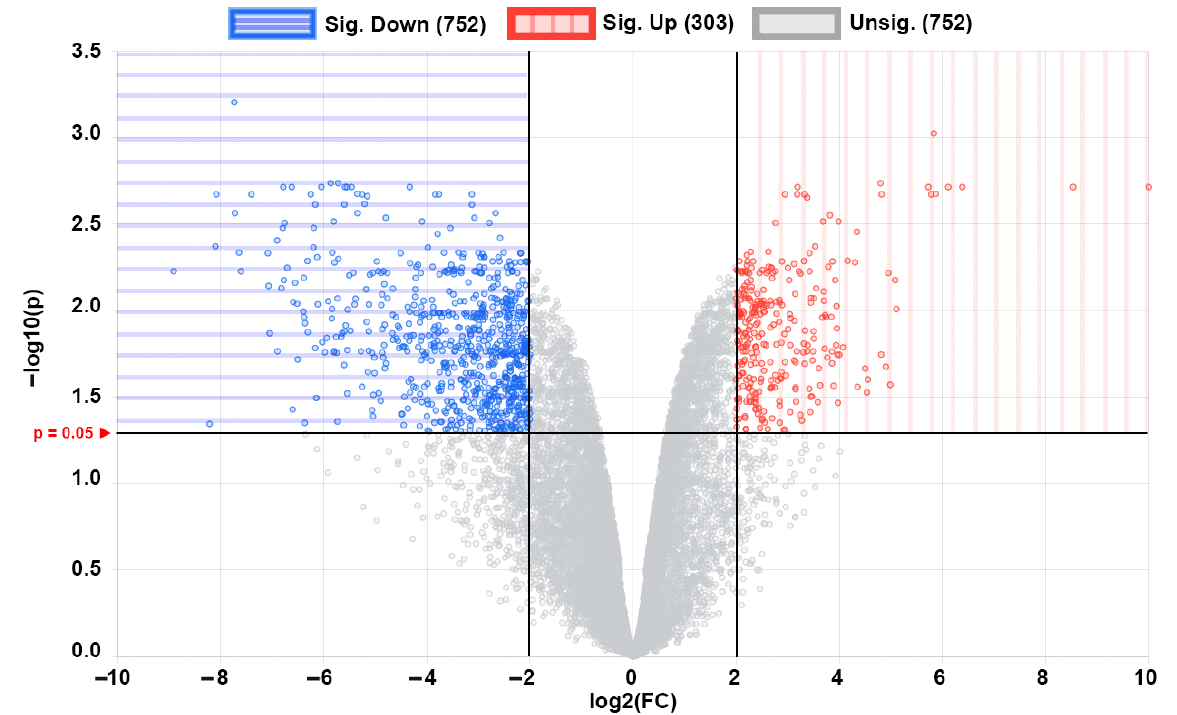
Figure 2. Volcano plot of all 1055 DEGs of phoenix spheres compared to auditory neurons. Each dot represents a gene. Blue area highlights 752 down-regulated DEGs while red area contains 303 up-regulated DEGs.